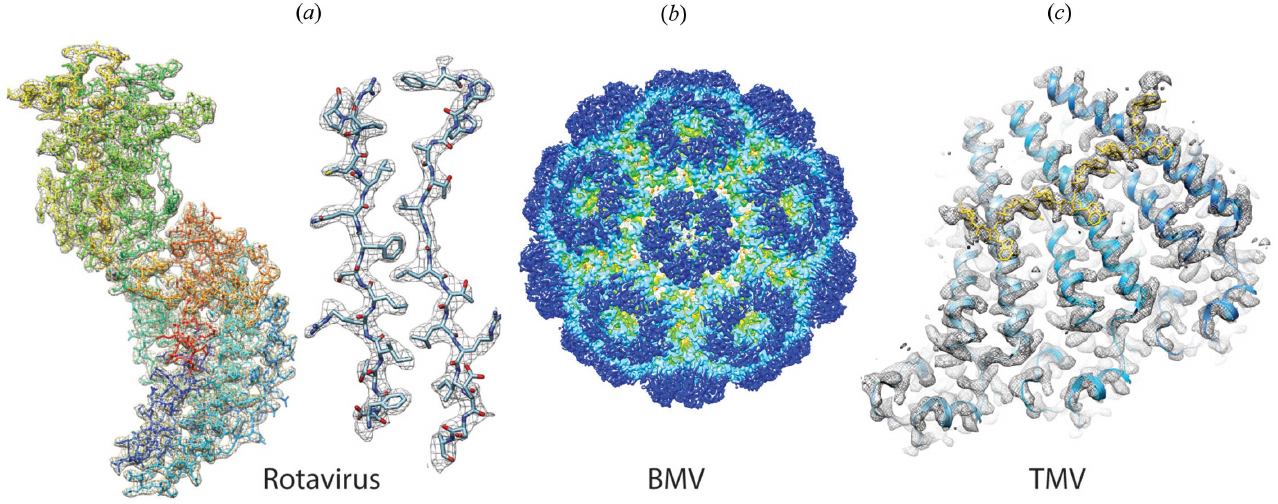
Figure 4 Examples of some large structures. ( a ) Human rotavirus (Grant & Grigorieff, 2015), ( b ) brome mosaic virus (Wang et al. , 2014) and ( c ) TMV (Fromm et al. , 2015), at resolutions of 2.6 A˚ , 3.8 A˚ and 3.4 A˚ , respectively. Not on same